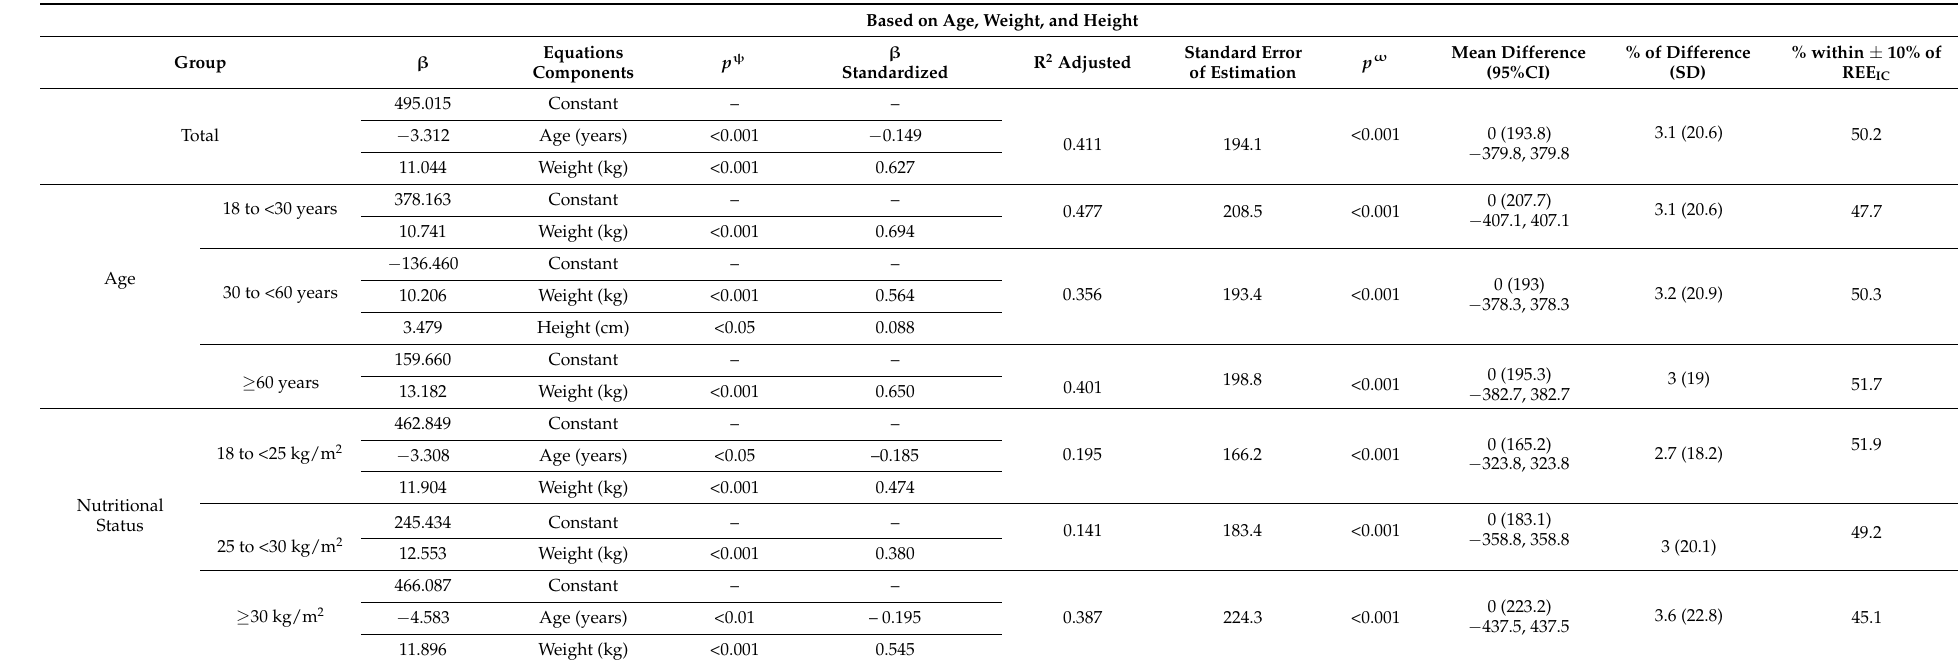
Table 6. Proposed formulas for resting energy expenditure